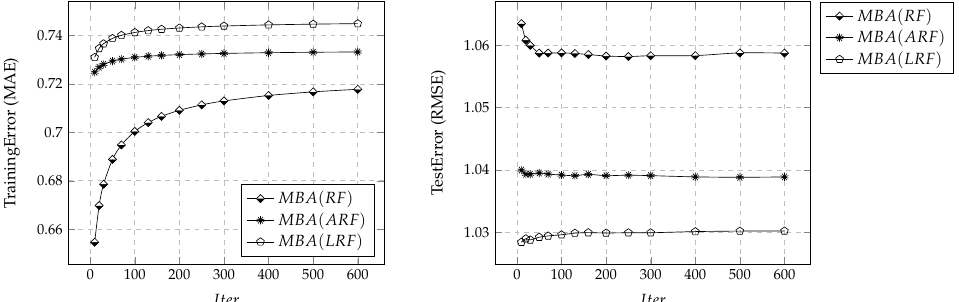
Figure A2. Comparison of RMSE in MBA(Vanilla) by Iter . The experiment was done after fixing n as: MBA(RF) with n = 3, MBA(ARF) with n = 7 and MBA(LRF) with n = 11, as found in Figure